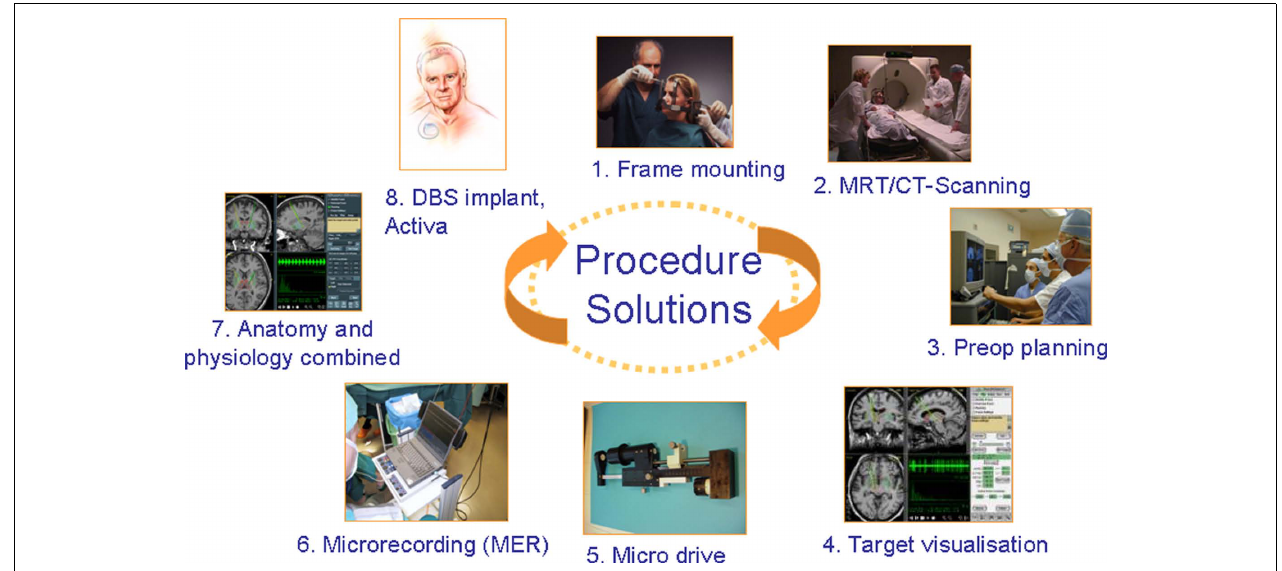
FIGURE 2 | Deep Brain Stimulator requires an multidisciplinary expert team and is a multi-step procedure involving stereotactic frame mounting (or “frameless” tools fixation); imaging, neurophysiological assessment, target verification prior to the DBS lead, and DBS system implantation.